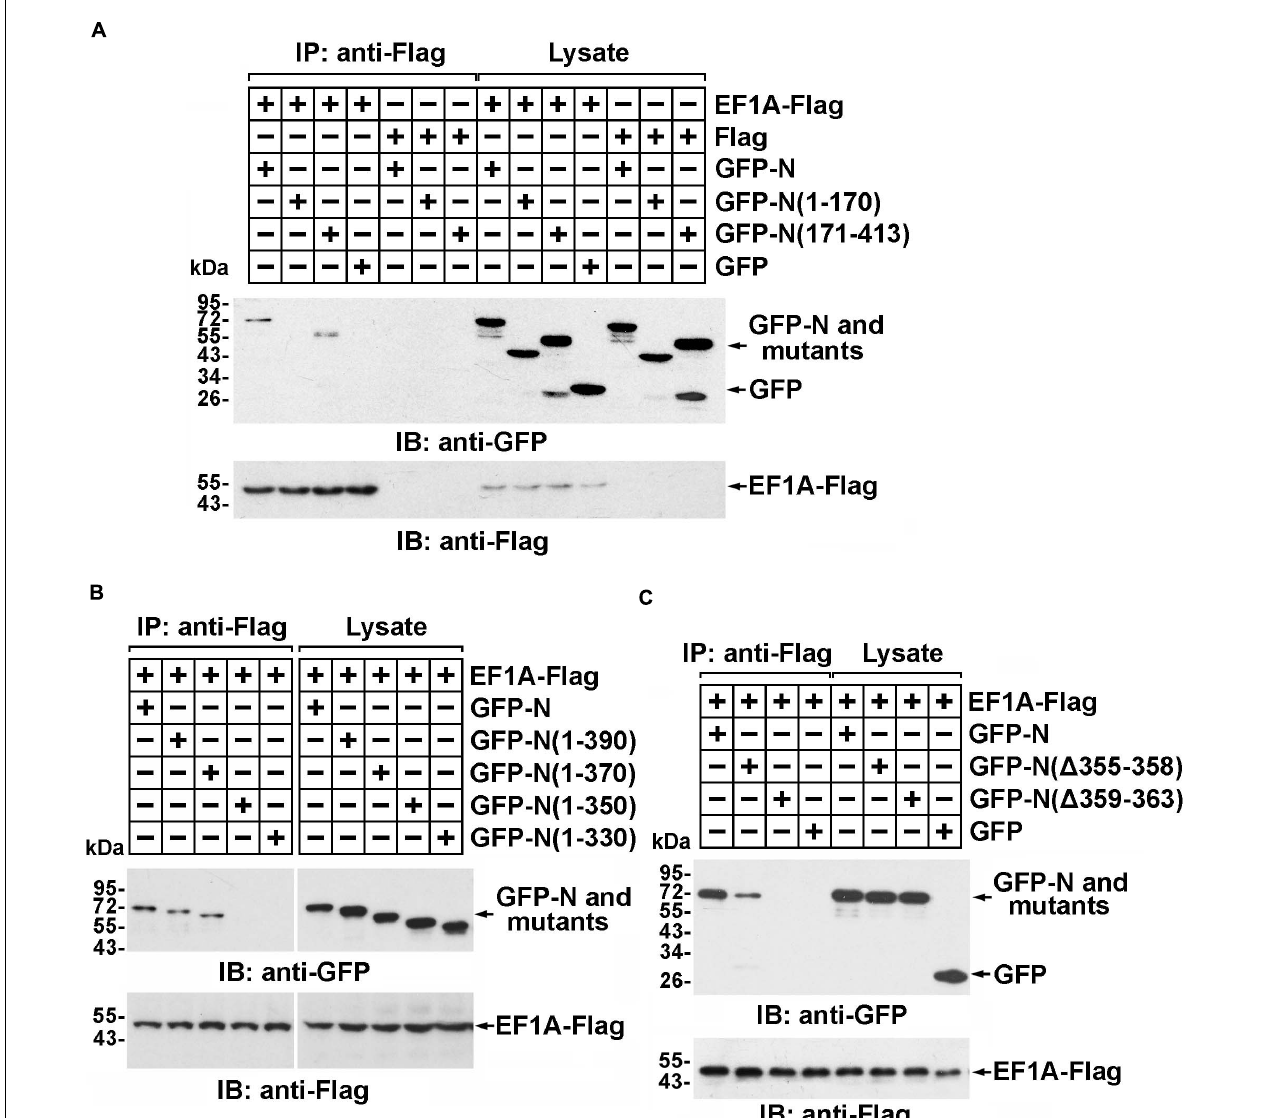
FIGURE 2 | Residues 359–363 of the MERS-CoV N protein and the C-terminal motif of EF1A are the crucial domains involved in the MERS-CoV N-EF1A interaction. (A,B) The C-terminus of the MERS-CoV N protein contributes to the association with EF1A. HEK293T cells were transfected with EF1A-Flag and GFP-N, mutant constructs, or GFP (negative control vectors). Forty-eight hours after transfection, the cells were lysed and incubated with anti-Flag beads. Then, the immunoprecipitates were detected by immunoblotting with anti-GFP and anti-Flag antibodies. (C) Anti-Flag immunoprecipitates prepared from lysates of HEK293T cells expressing the GFP-MERS-CoV N protein and EF1A-Flag or mutants were assayed by immunoblotting. The GFP-tagged N protein, Flag-tagged EF1A, and mutants were detected with anti-GFP and anti-Flag